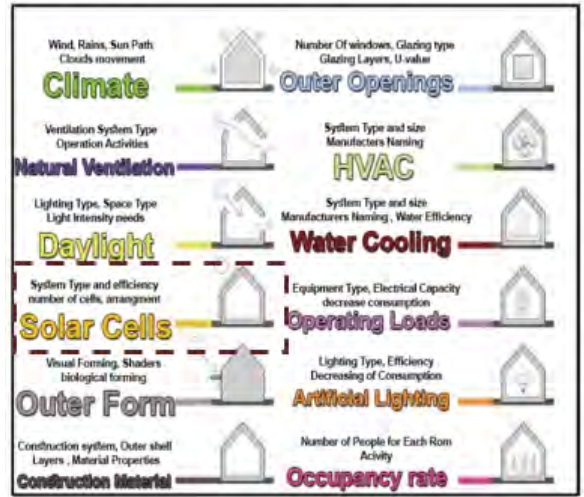
Figure 2. The most important strategiesto be upgraded to achieve sustainable design principles (Rashwan, 2014) This research will focus on how solar energy can best be exploited by solar